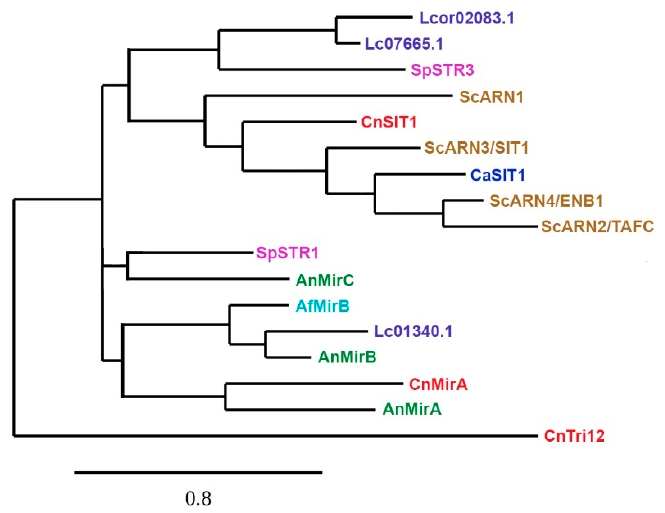
Figure 3. Phylogenetic analysis of characterised siderophore transporters from S. cerevisiae (Sc, brown), S. pombe (Sp, pink), C. albicans (Ca, blue), C. neoformans (Cn, red), A. fumigatus (Af, torquoise) , and A. nidulans (An, green). Putative siderophore transporters from L. corymbifera (Lc, purple) are also included. CnTri12 is a major facilitator not belonging to the SIT-family of proteins and serves as an outgroup. All sequences were aligned using MUSCLE (v.3.8.31, Marceille, France). Phylogenetic (v3.1 / 3 / 0 aLRT, Marceille, France). The WAG substitution model was selected assuming an